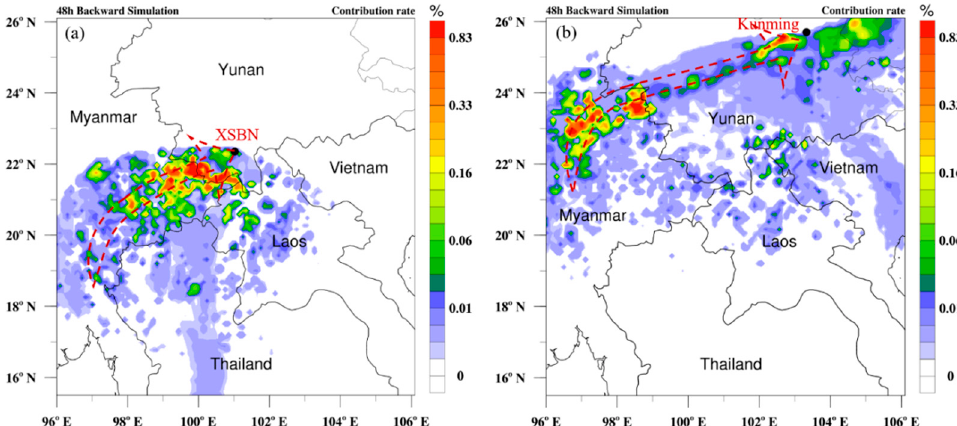
Figure 8. Spatial distribution of contribution rates (color contours) to PM 2.5 concentrations in ( a ) XSBN and ( b ) Kunming with the major pathways of regional transport (red dash arrows) simulated by the FLEXPART-WRF model from 08:00 of 24 March to 08:00 of 26 March.